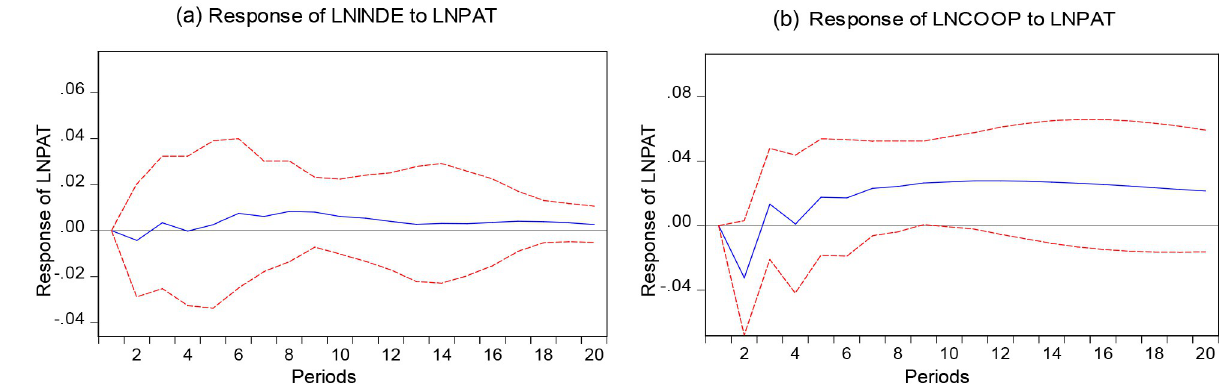
Fig 2. Impulse responses of LNINDE, LNCOOP to